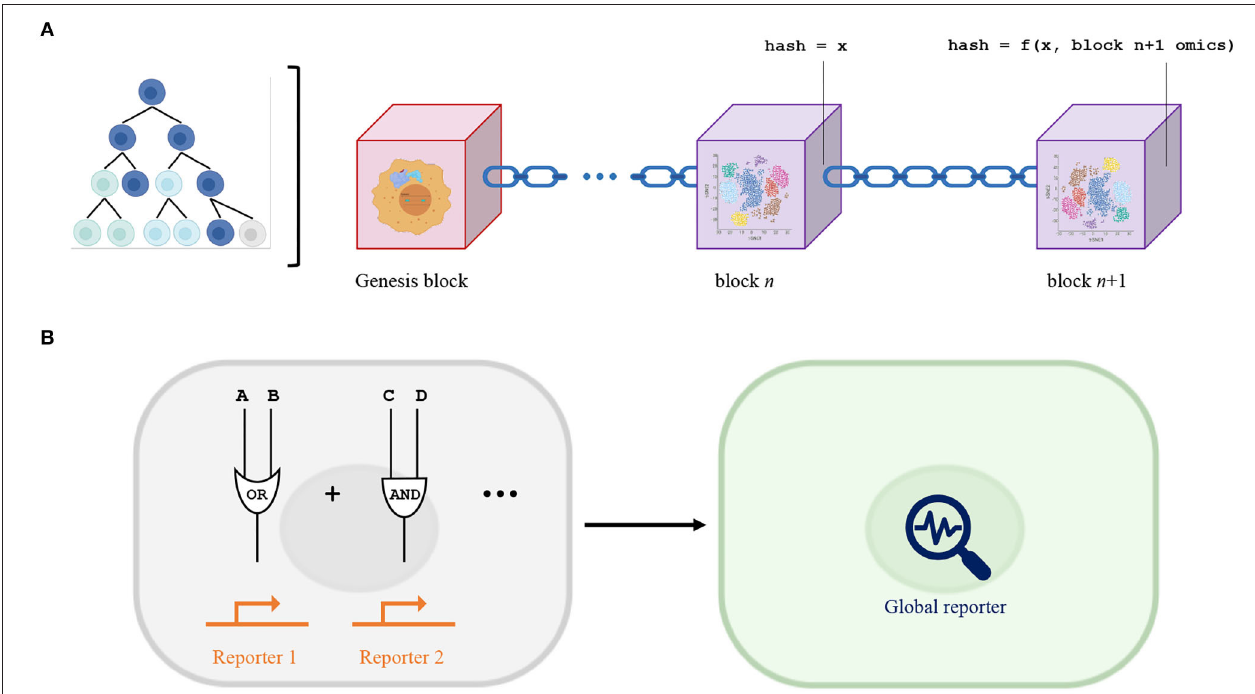
FIGURE 1 | (A) Blockchain model of cancer evolution. Founder mutation (represented by lavender and turquoise fusion protein) initiates genesis block. Contents of every block encompass the complete single-cell omics of the cancer at a certain time point. Each block is marked by a unique hash that is a function of the hash of the previous block and its own contents. Proof-of-work determines the timeframe elapsed between each block. The entire ledger is decentralized across every cancer cell. (B) Model for logic-based smart contracts integrated with biological Boolean logic gates. Complex synthetic biological circuits can involve many unique signal inputs into multiple Boolean logic gates of different types, each requiring an independent reporter (orange). Implementing logic-based smart contracts eliminates the need for individual reporters to validate an individual logic gate, potentially allowing for a general global, blockchain-based reporter (blue) that can model dynamic and multiplexed